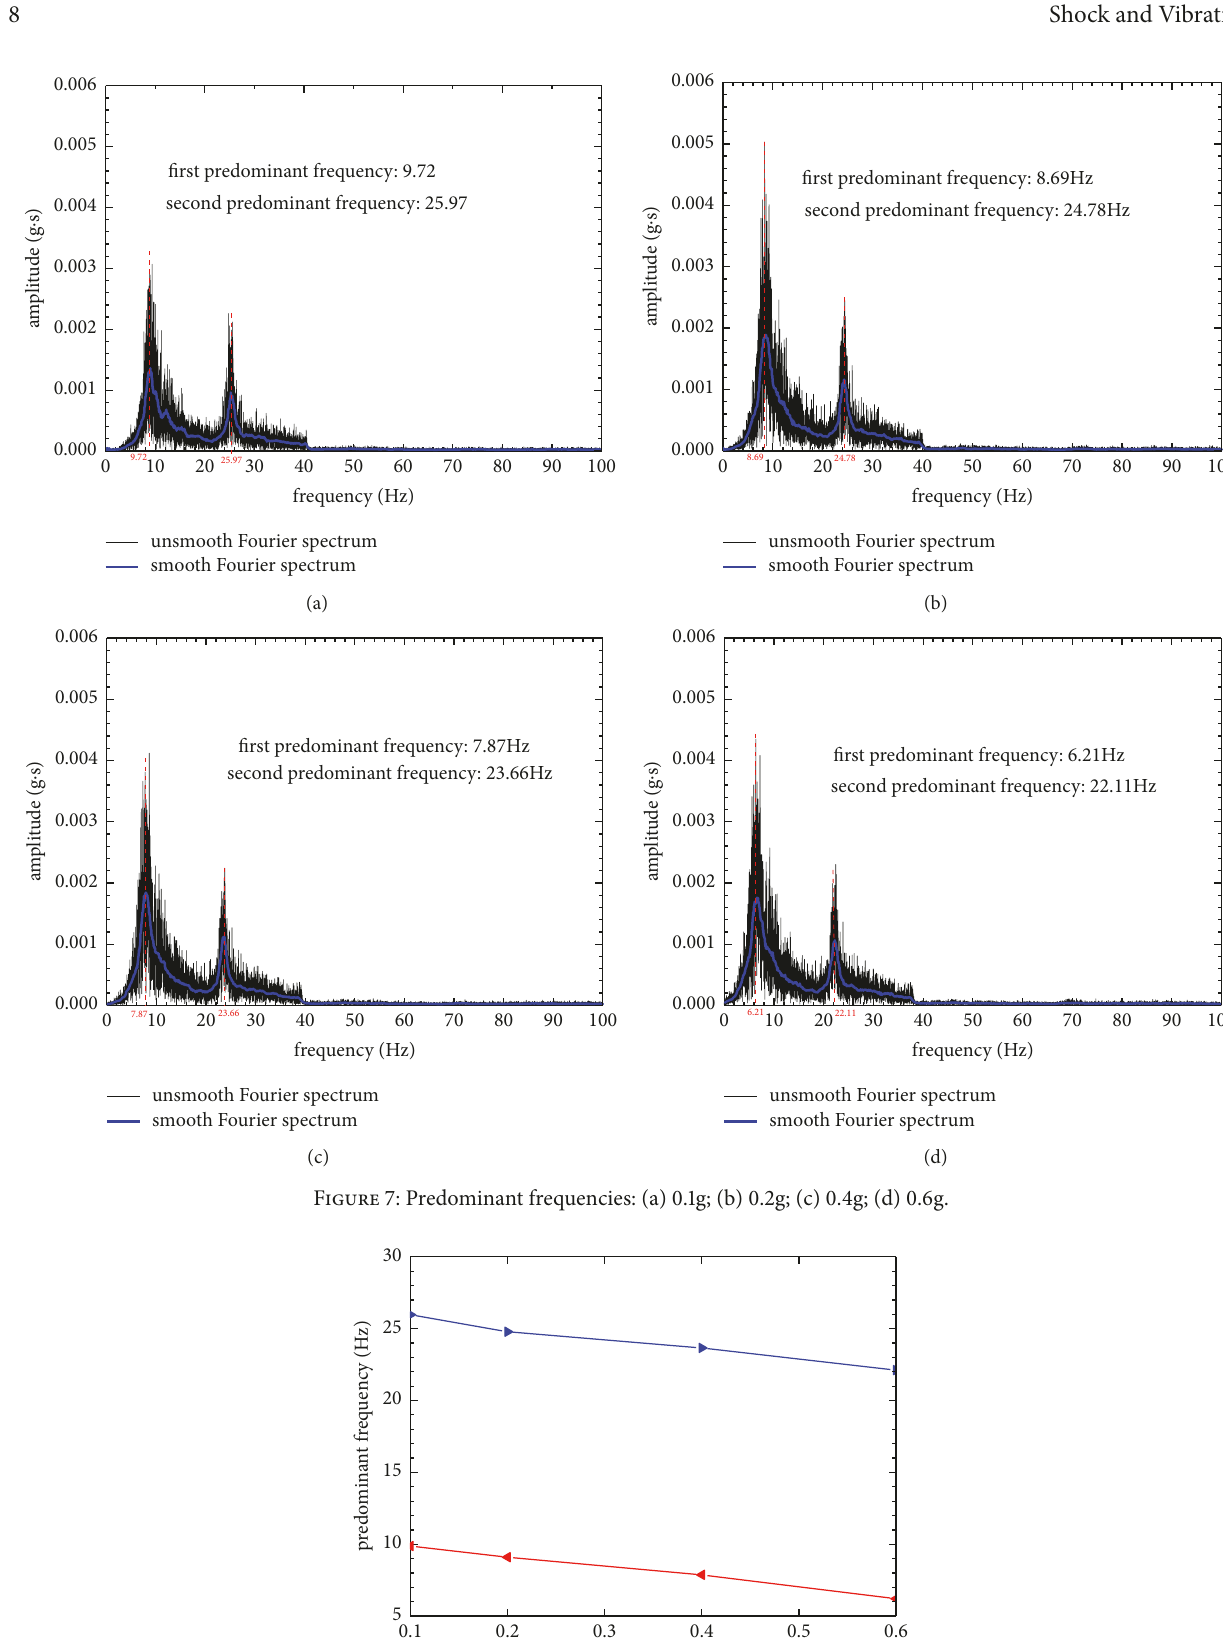
Figure 8: Predominant frequencies with input